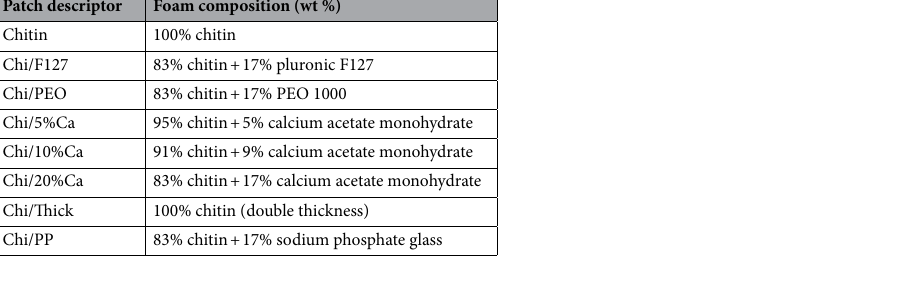
Table 1. Chitin patch